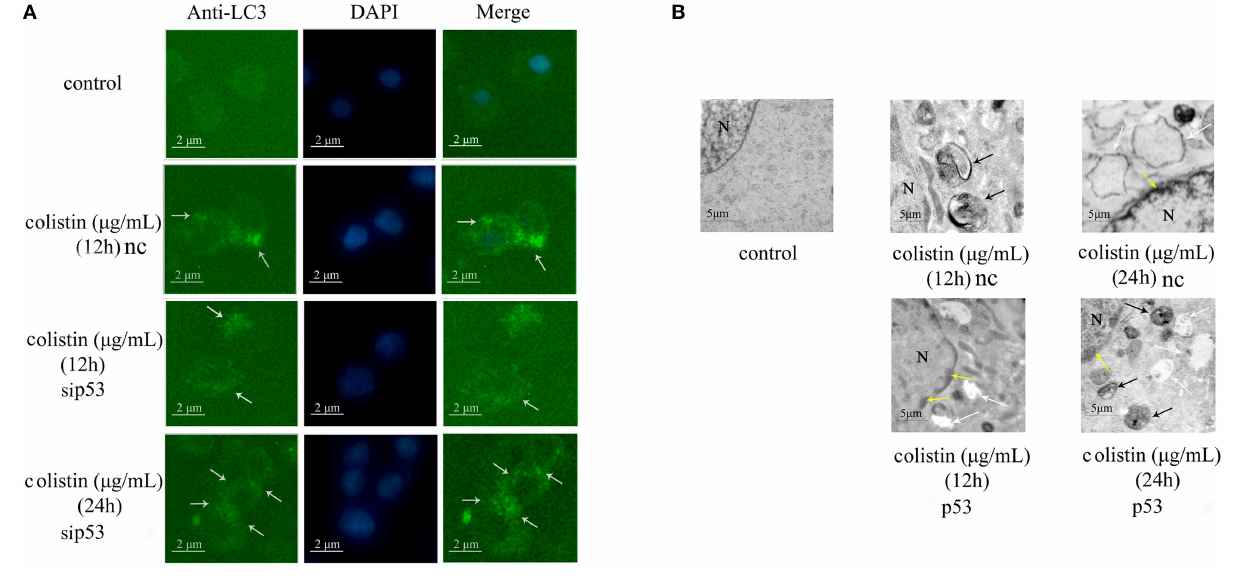
FIGURE 2 | Morphologic analysis of sip53-induced autophagy in colistin-treated PC-12 cells. (A) LC3 staining of p53 silenced cells or negative control siRNA following colistin treatment for 12 and 24h. Arrow indicates LC3 punctum. (B) Transmission electron microscopy observations of the control PC-12 cells, PC-12-nc cells treated with colistin at 12 and 24h and PC-12-sip53 cells treated with colistin (12 and 24h). Black arrows indicate the typical autophagosomes containing intracellular components and organelles, whereas apoptotic changes such as chromatin condensation (yellow arrows) and cytoplasmic vacuolization (white